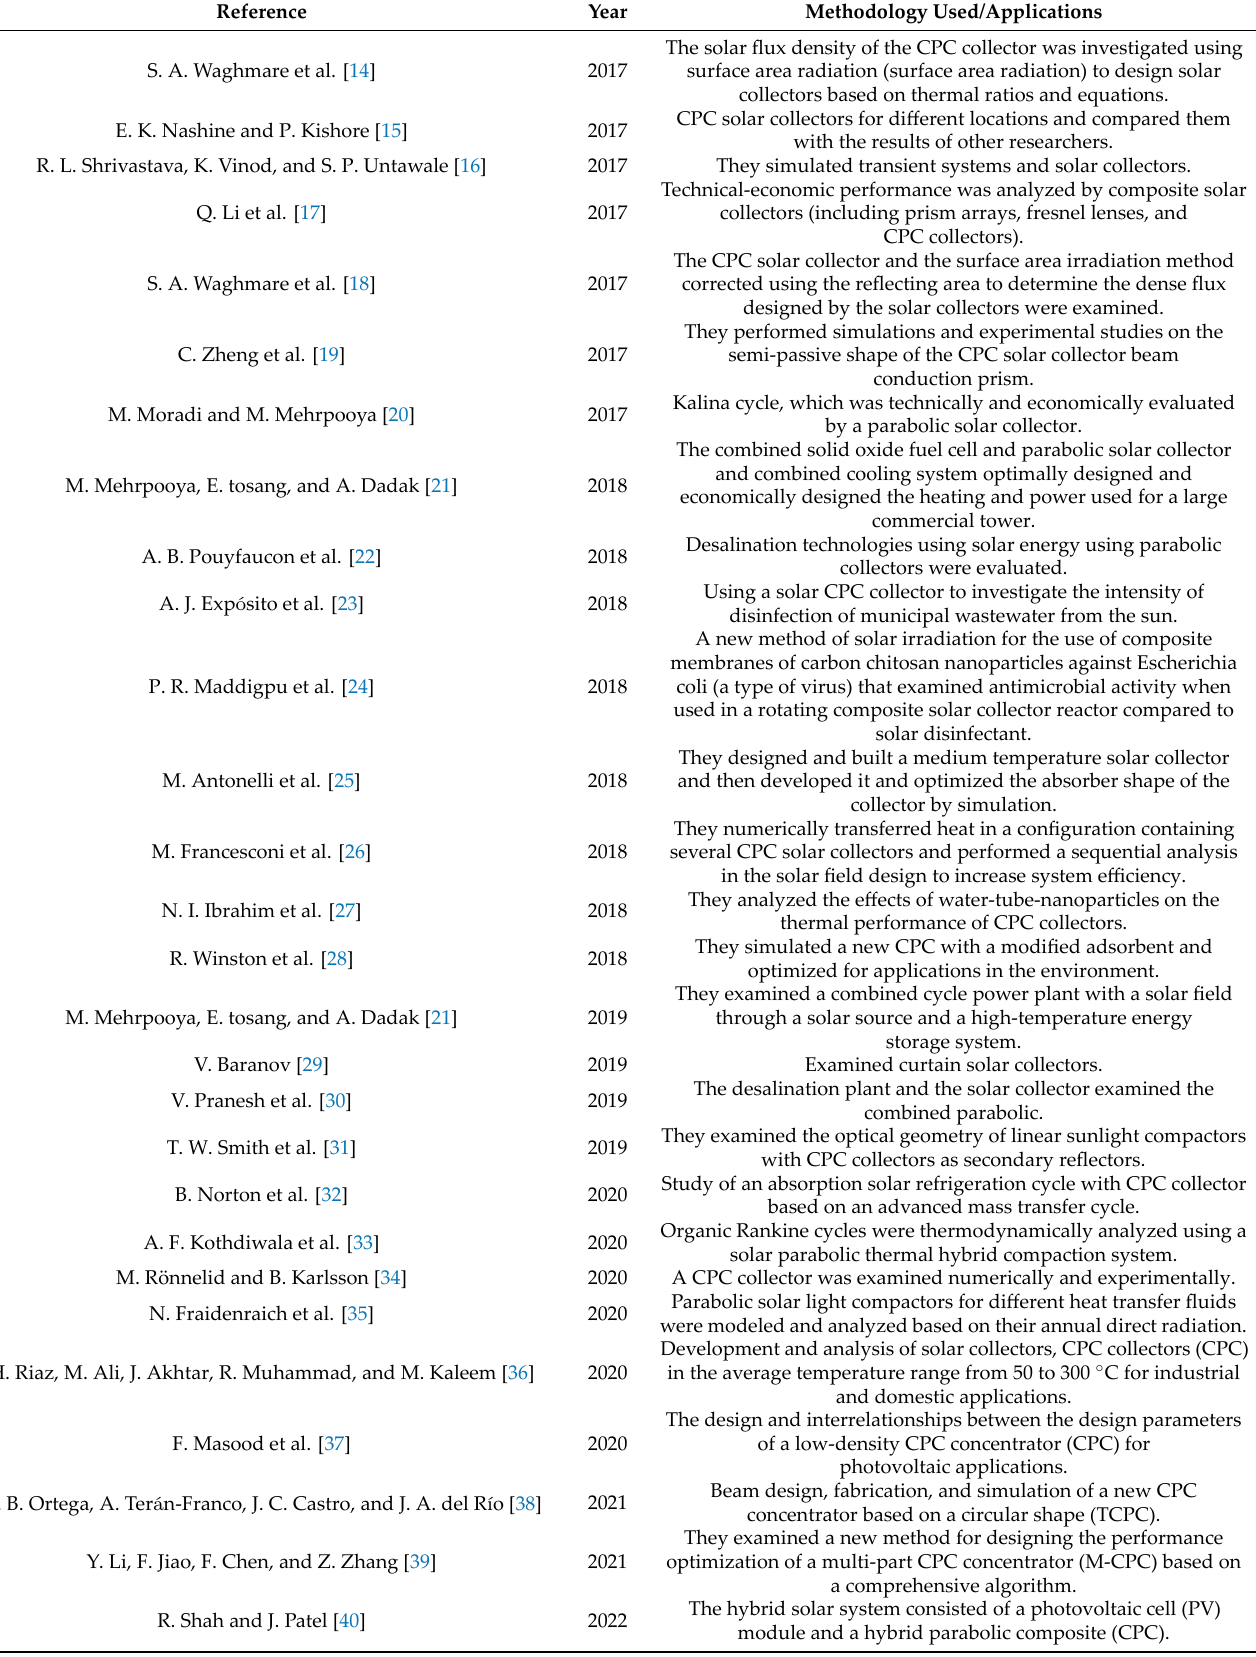
Table 1. Summary of research on CPC